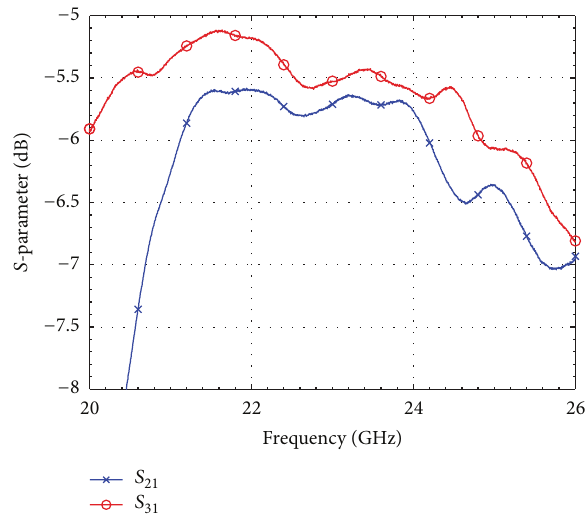
Figure 14: Measured transmission coefficient of the hybrid coupler.